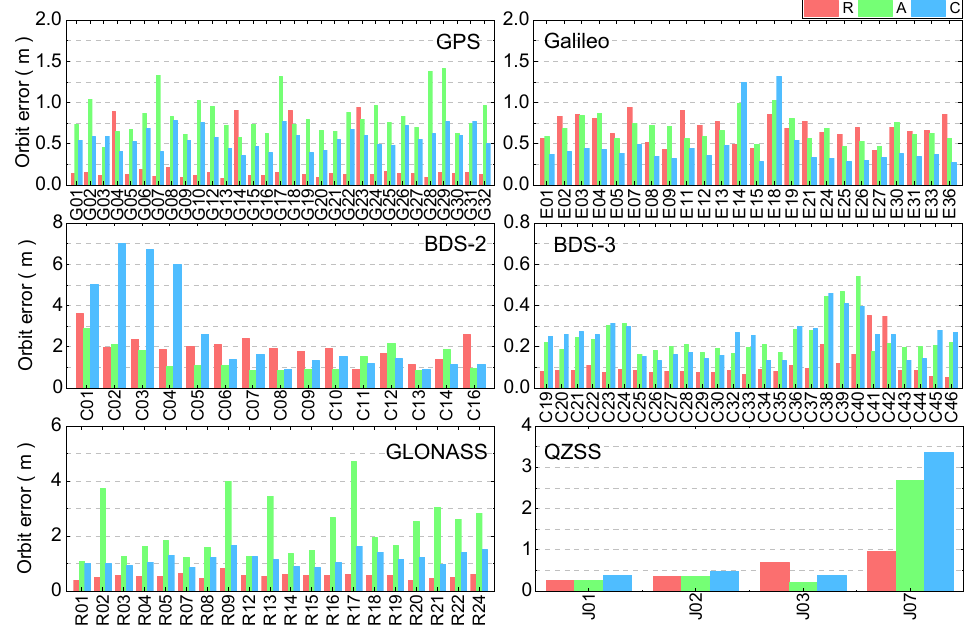
Figure 7. Broadcast orbit accuracy of GNSS five systems. Table 4. Average accuracy of DOY 283–289 broadcast orbit for Multi-GNSS satellites (unit: m). System Radial Along-Track